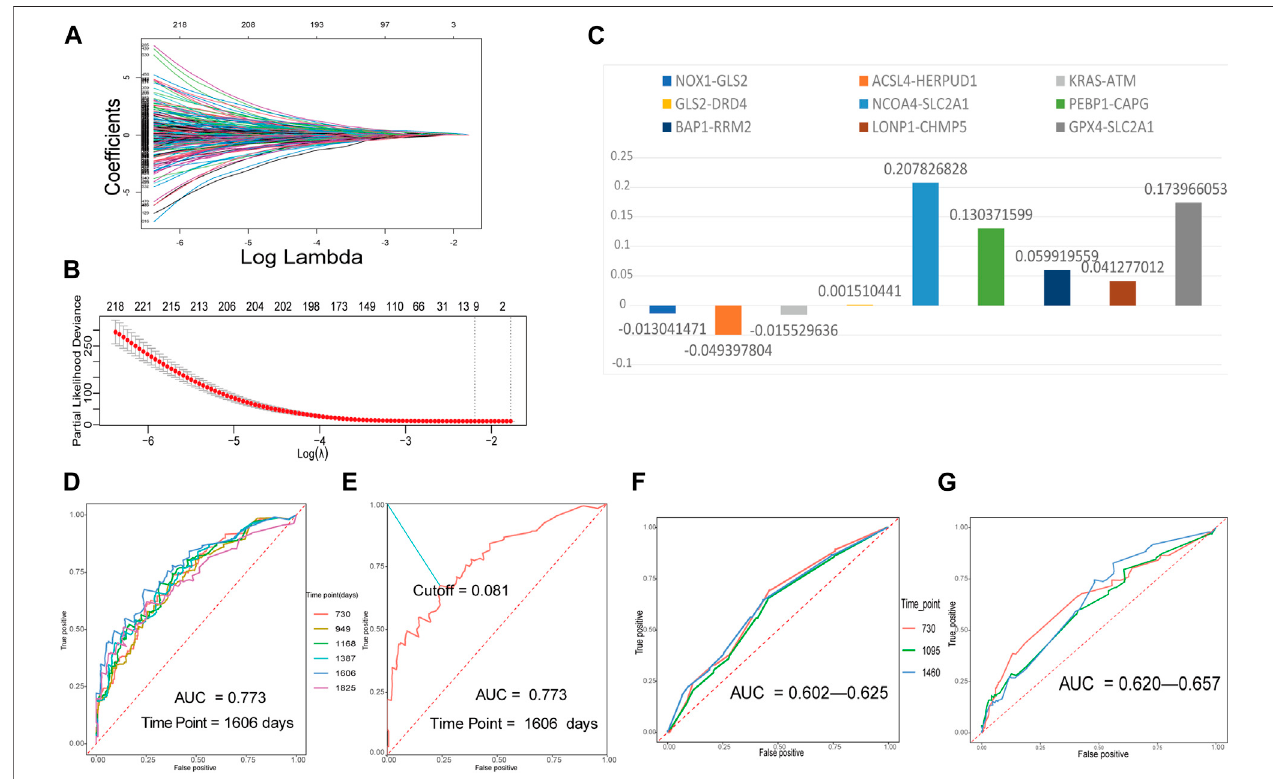
FIGURE2| Buildingaferroptosis-relatedgene-pairindex(FRGPI)inthetrainingsetandverifyingFRGPIintheROCcurves. (A) Thediagramoflambdaandcoef. (B) Performing10-fold CVtocalculatethepartiallikelihooddeviancecorrespondingtodifferentmodels.Thedeviancewasthesmallestwhenninegenepairswereincluded. Theminimumoflambdawas0.1115. (C) OurprognosticFRGPIwasmadeupofnineFRGPsandcorrespondingcoefvalues. (D) Thetime-dependentROCcurvesofthe trainingset. (E) Wede fi nedtheoptimal cut-off0.081inthetrainingsetcurvewiththebestAUCand “ 1606 ” asthetimepoint. (F,G) Time-dependentROCcurvesof validation